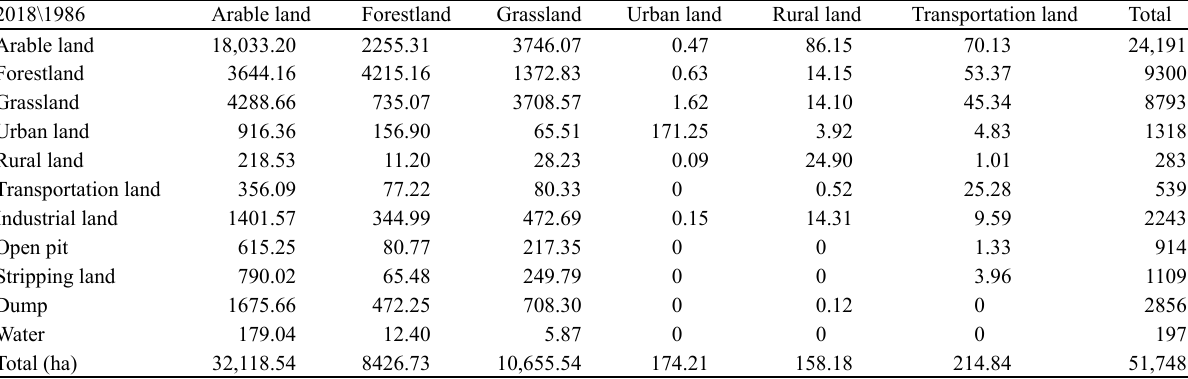
Table 3 Land use conversion from 1986 to 2018